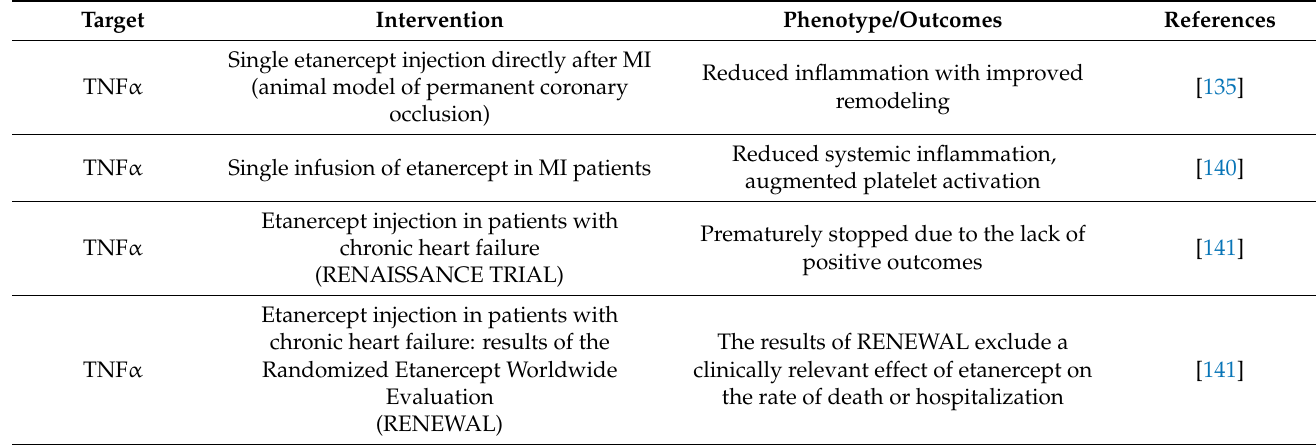
Table 1. Summary of major experimental studies testing